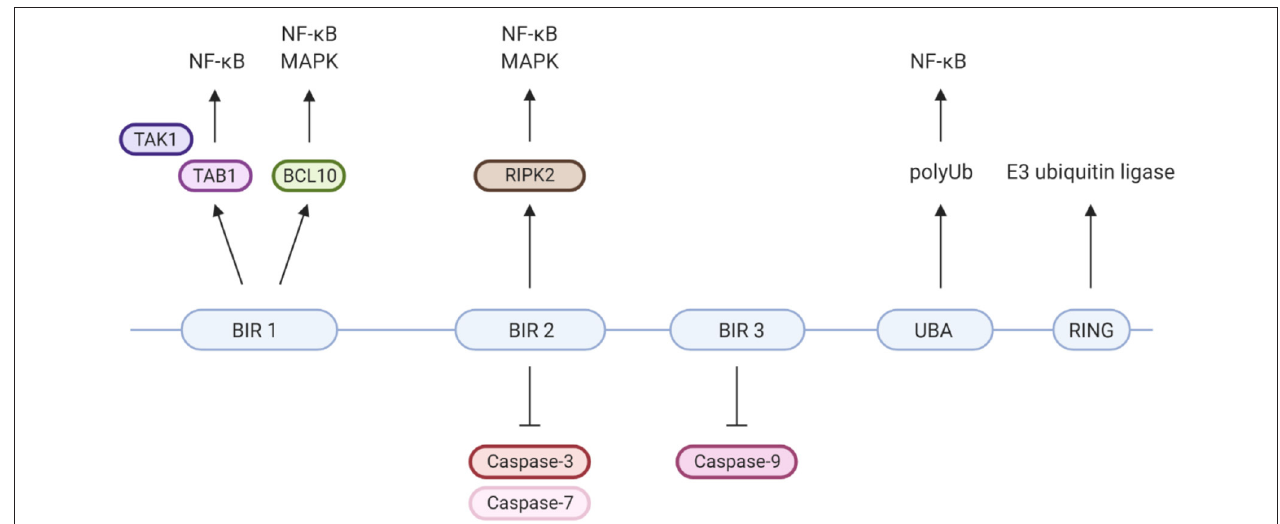
FIGURE 2 | XIAP’s protein domains and their individual specific protein interactions and functions. Well-known is that XIAP’s BIR2 and 3 domains directly inhibit caspase-3, − 7 and − 9 ( 18, 25–27). BIR1 has been isolated as the BCL10-binding region within XIAP. This interaction plays a role in the Dectin-1 signalling pathway (28). Furthermore, BIR1 recruits the TAB1/TAK1 complex, which is essential for activation of the NF- κ B and MAPK pathways (29–31). BIR2 interacts with RIPK2, which forms a necessary step in the NOD1/2 signalling pathways leading to NF- κ B and MAPK activation ( 5, 32, 33). The UBA domain is able to directly bind polyubiquitin chains and is required for activation of NF- κ B, likely via its binding to polyubiquitinated NEMO ( 34). The C-terminal RING finger domain of XIAP has E3 ubiquitin ligase function, enabling XIAP to target proteins for proteasomal degradation or alter protein function (35). For example, the ubiquitin ligase activity of XIAP is critical for NOD2 mediated activation of NF- κ B, via the polyubiquitination of RIKP2 ( 36). Created with